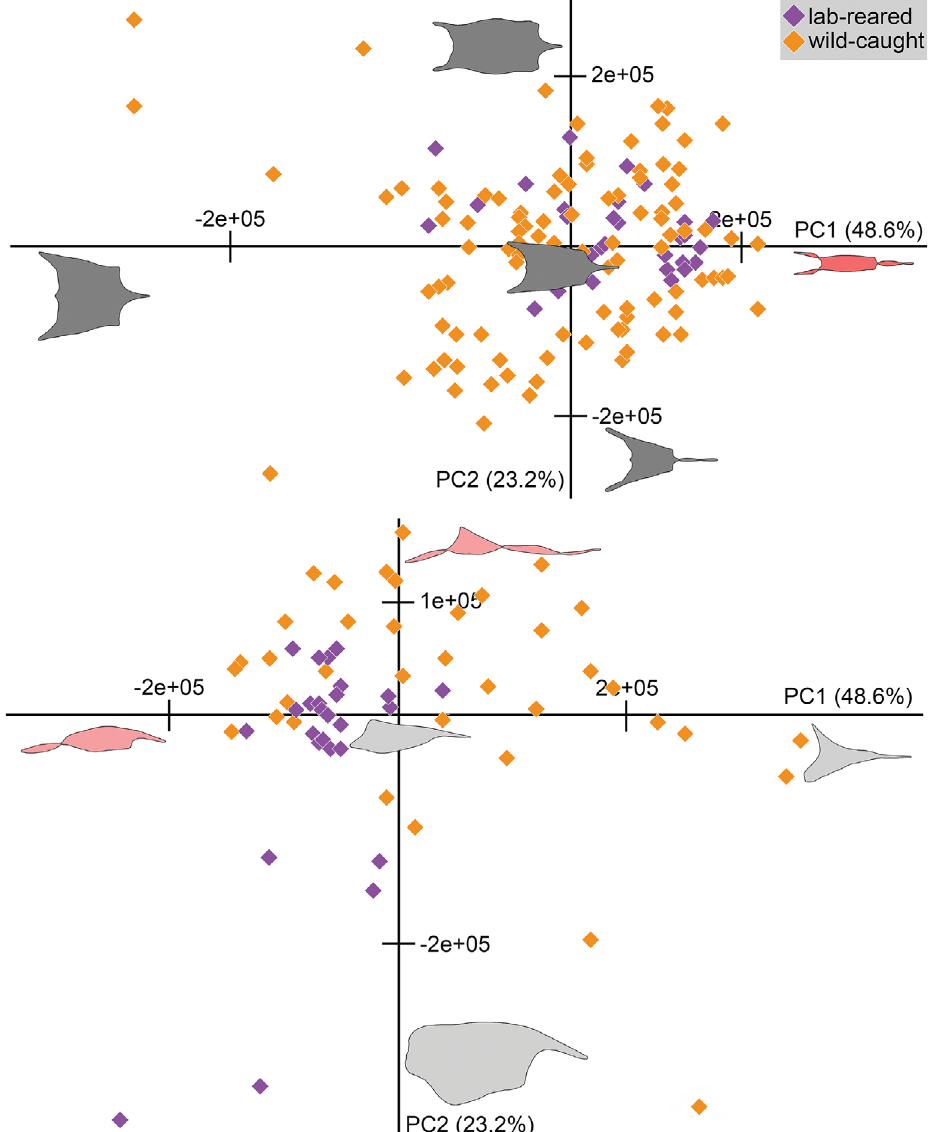
Figure 7. Plot of principal components (PCs) from the principal component analysis (PCA) on the SHAPE analysis of shield outlines of Stomatopoda. Shapes included are from graphical component loadings and depict the mean shape of the principal component and +/-2 standard deviations of the mean shape. A: PC1 plotted against PC2 from the dorsal analysis. B : PC1 plotted against PC2 from the lateral analysis. Color coding: dark grey: possible shapes of the dorsal analysis; red: impossible shapes of the dorsal analysis; light grey: possible shapes of lateral analysis; light red: impossible shapes of lateral